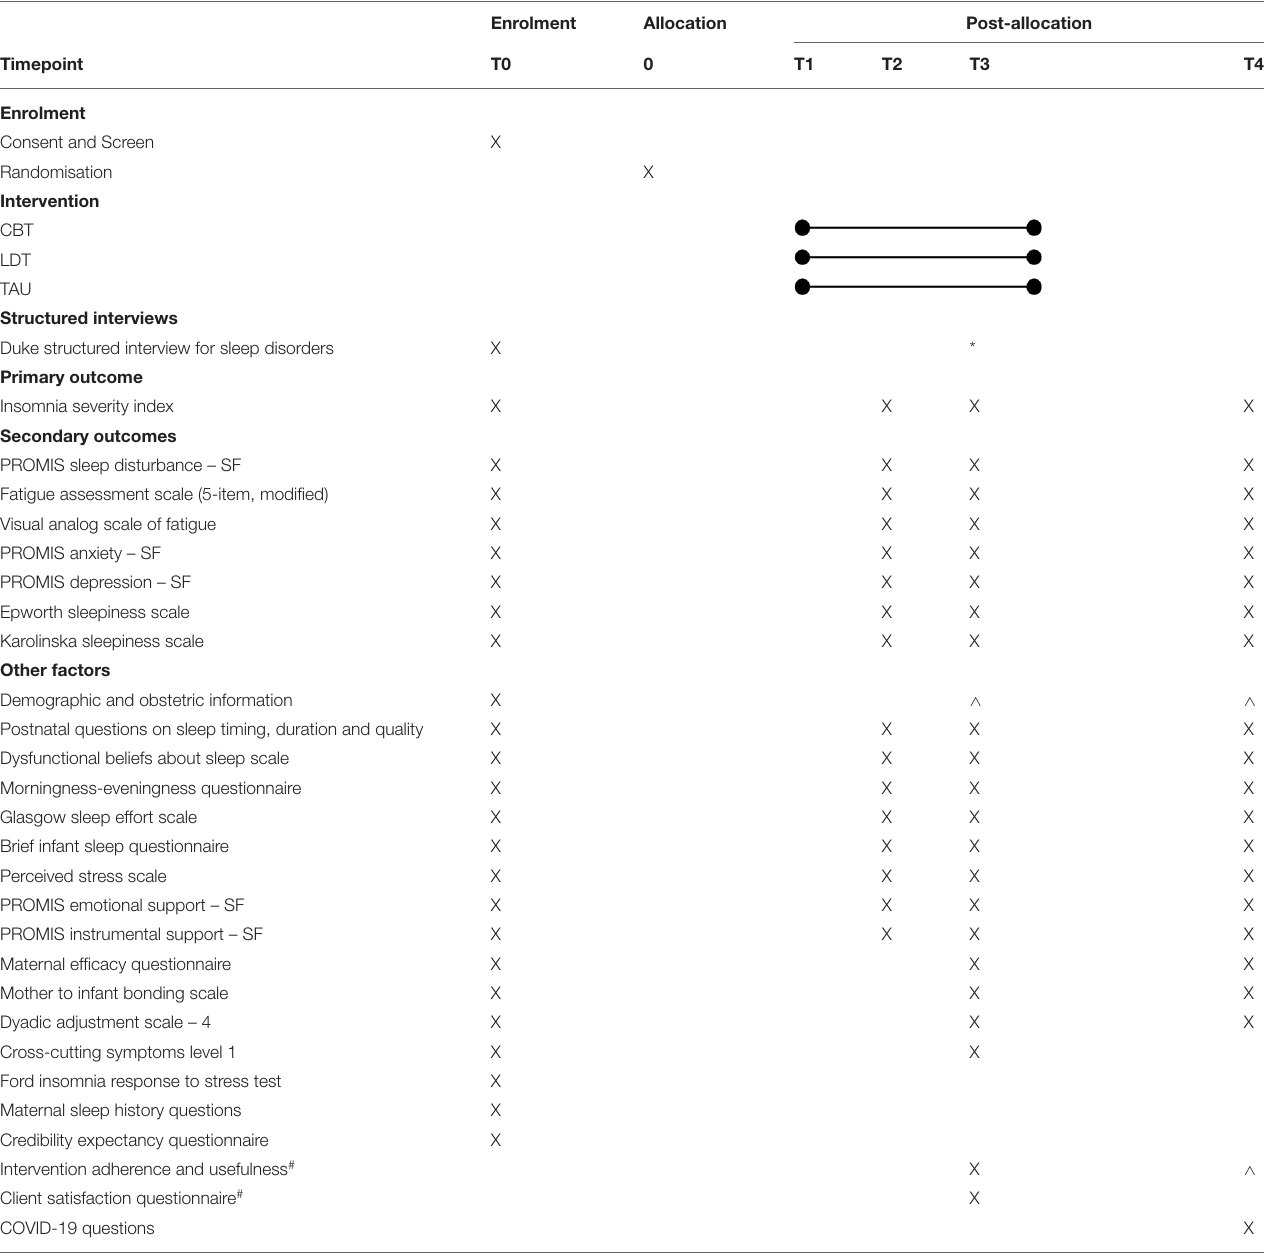
TABLE 1 | Timing of measurements.